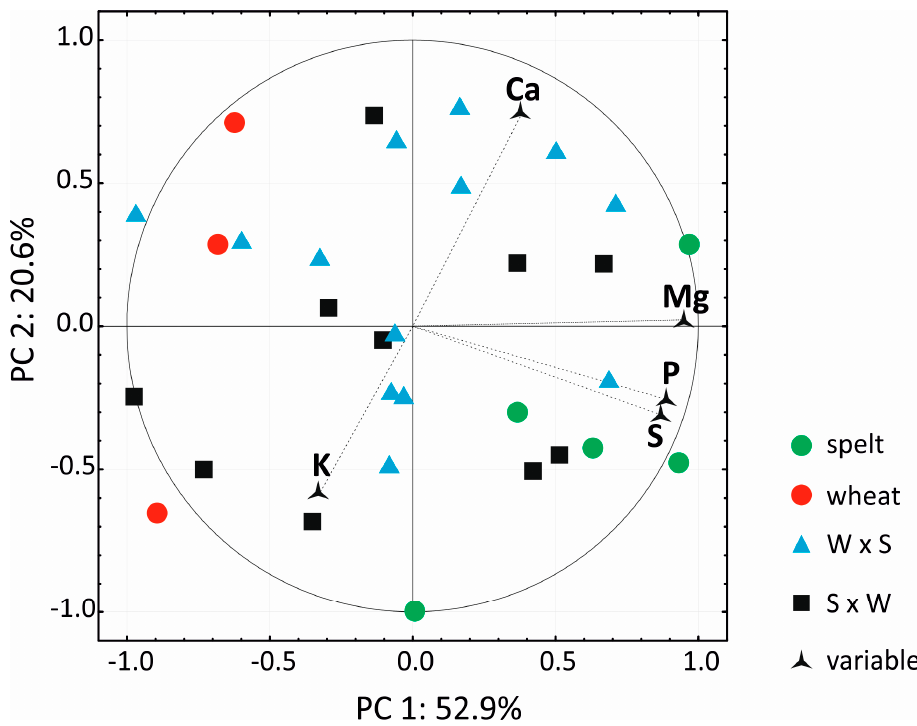
Figure 2. Biplot presenting PCA results for the contents of the five macro elements in the grains of the studied cereals. W × S—wheat × spelt; S × W—spelt × wheat.